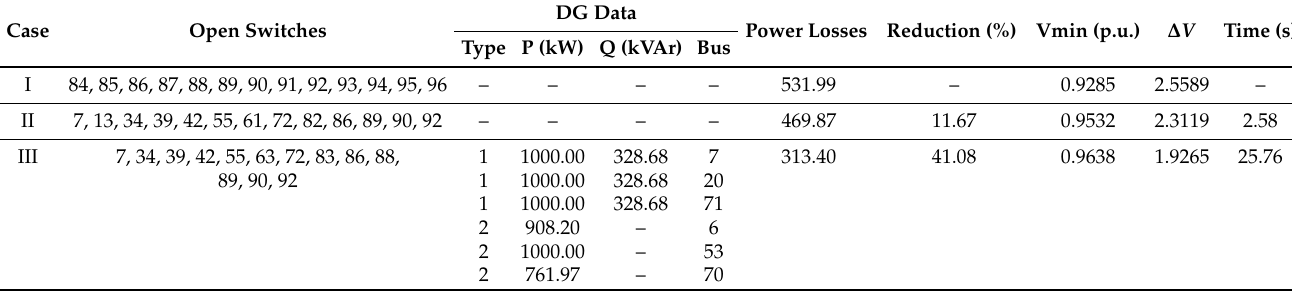
Table 5. Results for the 83-bus test system.